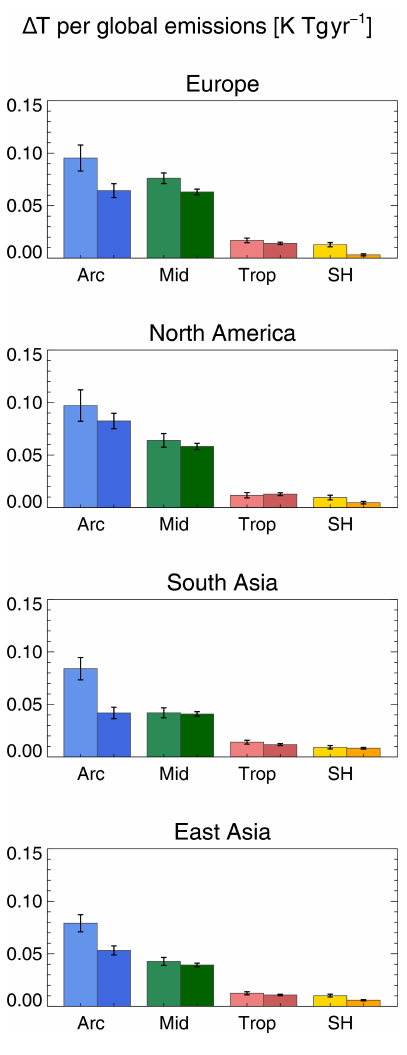
Figure 2. Regional surface temperature response per global BC emissions (K per Tgyr − 1 ). The emission location (Europe, North America, South Asia, East Asia) is given at the top of each plot. The response region (latitude band) is given on the x axis. The emission rate is doubled in the right-hand side bars (darker colours) compared to the left-hand side bars (lighter colours). The error bars represent the standard error of the mean.